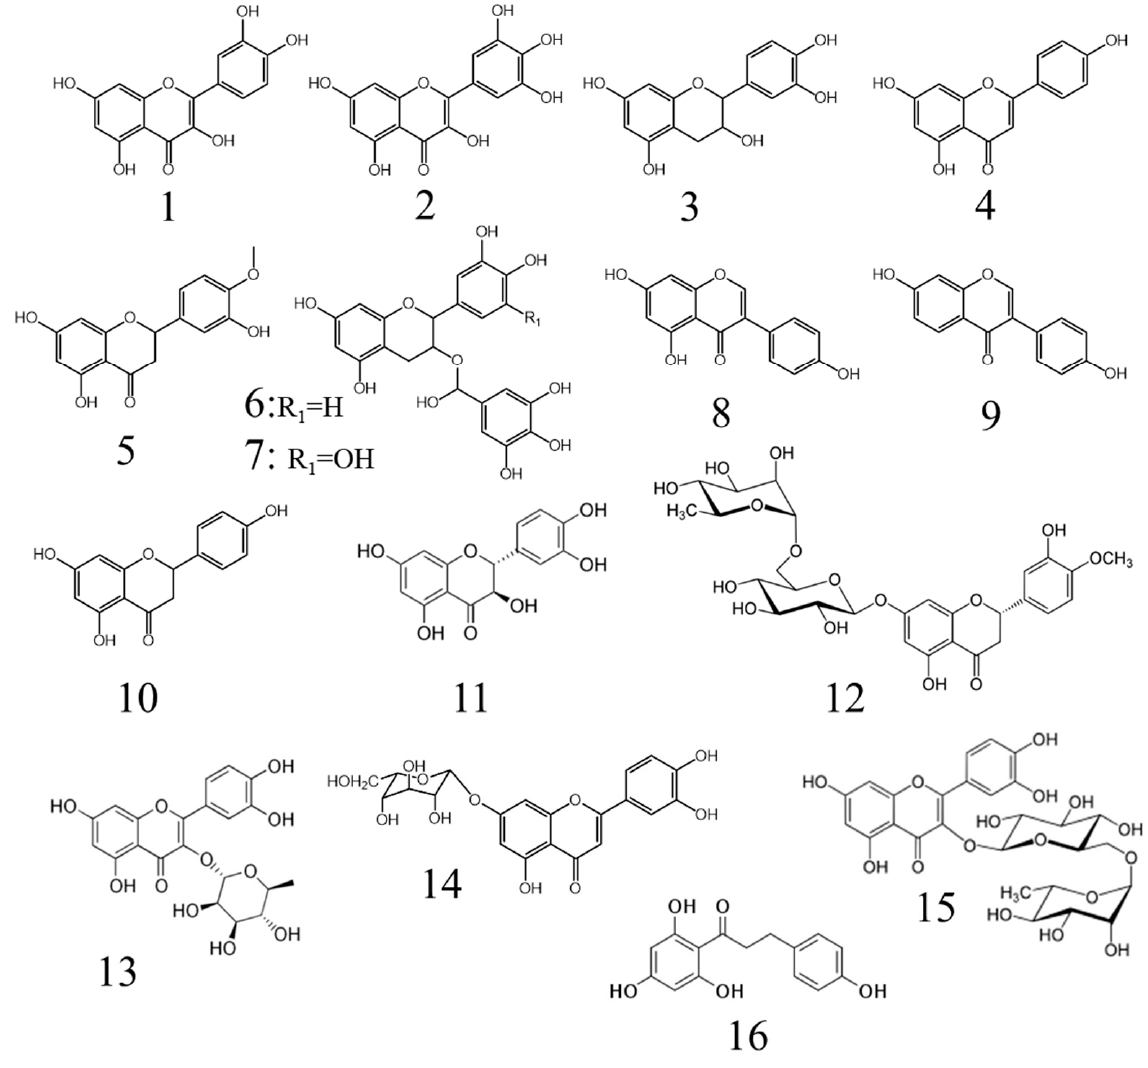
Figure 4. Chemical structures of flavonoid antioxidants. 1 : quercetin, 2 : myricetin, 3 : catechin, 4 : apigenin, 5 : hesperetin, 6 : epicatechin gallate, 7 : epigallocatechin gallate, 8 : daidzein, 9 : genistein, 10 : naringenin, 11 : dihydroquercetin (taxifolin), 12 : hesperidin, 13 : quercitrin, 14 : rutin, 15 : luteolin-7- O -glucoside, 16 : phloretin.